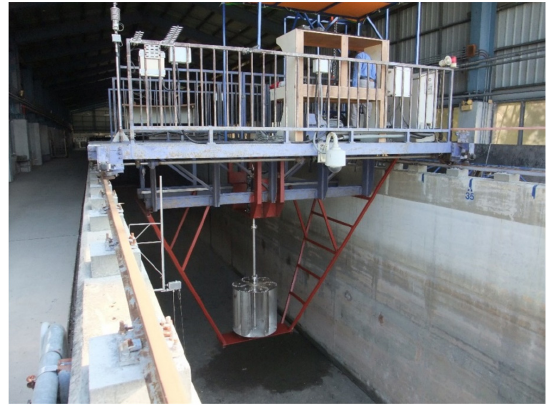
Figure 6. Towing tank experimental platform.